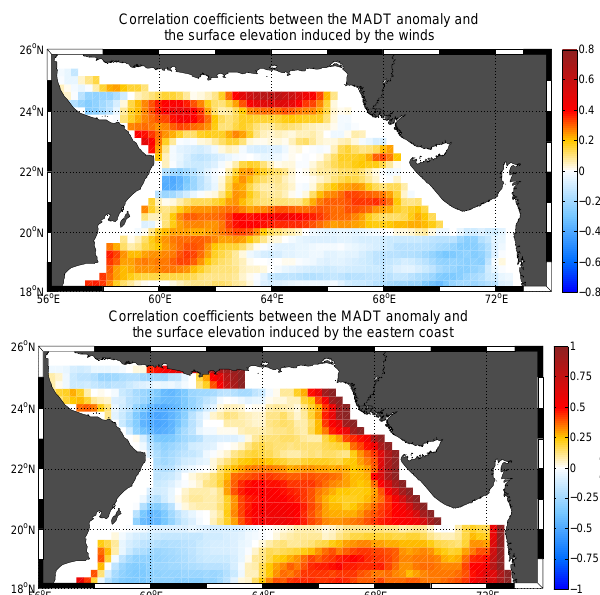
Figure 12. Correlation between the MADT from AVISO and the surface elevation anomaly created by the wind stress (top) and by the waves along the eastern coast (bottom) using the Fu and Qiu (2002)